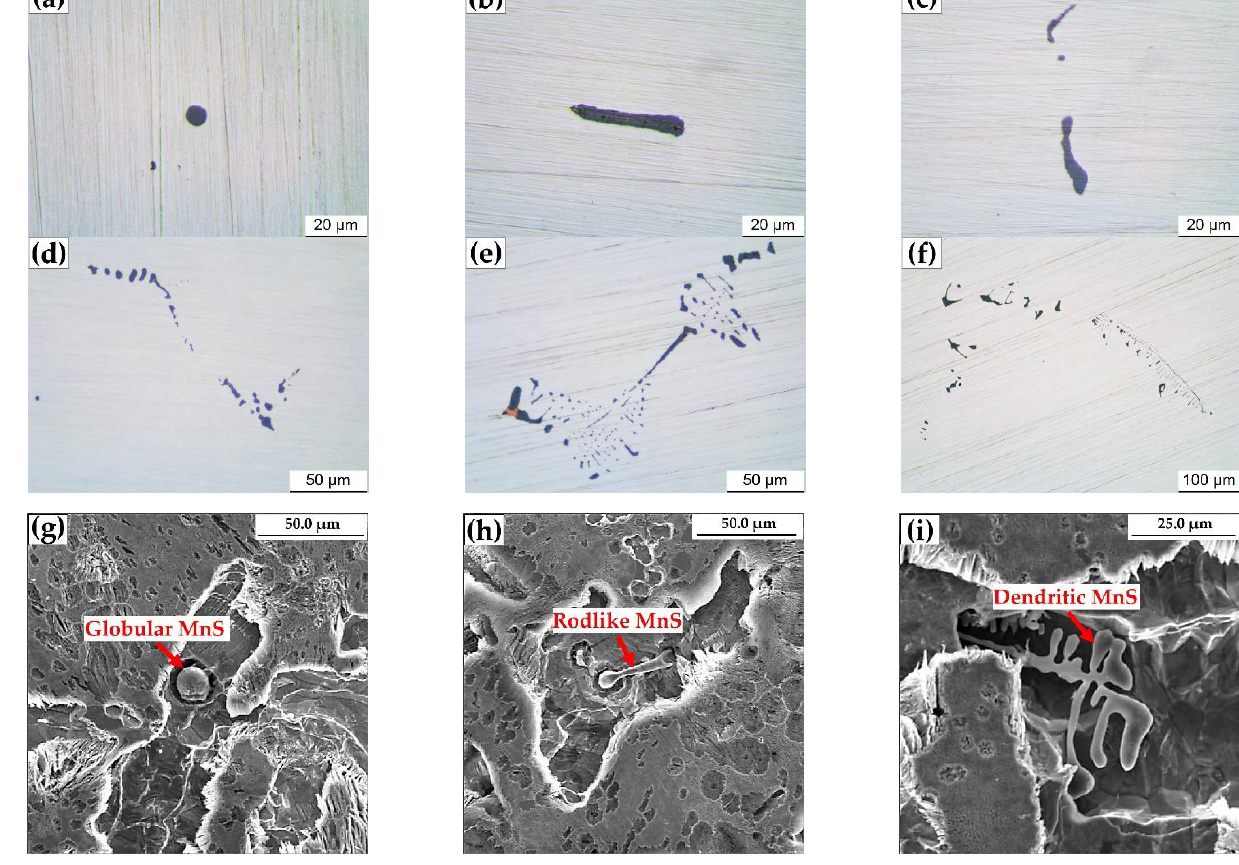
Figure 3. Typical 2D and 3D morphologies of MnS inclusions in the slab of medium carbon struc- tural steel 45#. ( a – f ) 2D morphologies, ( g – i ) 3D morphologies.